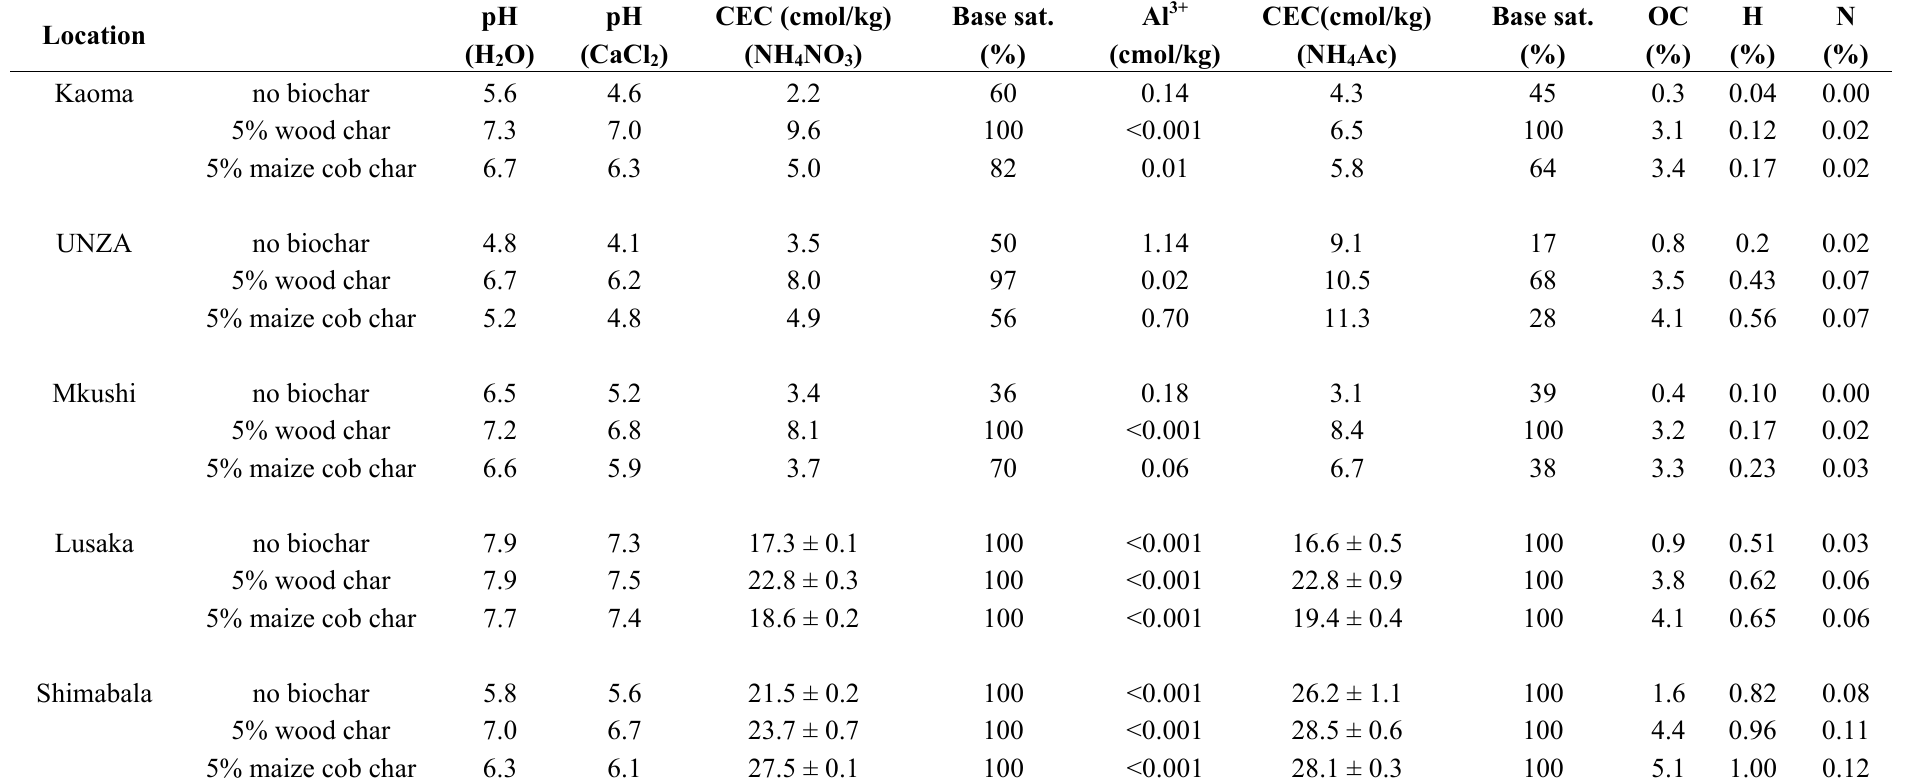
Table 4. Chemical characteristics of soils with 5% biochar and controls with no biochar for both samples taken in the field and samples mixed with the biochar in the